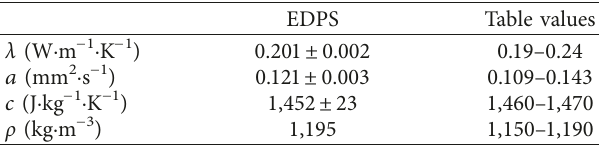
Figure 1: Design of experimental EDPS apparatus and setup of the Table 1: Thermophysical properties of PMMA determined by the EDPS method and table values.